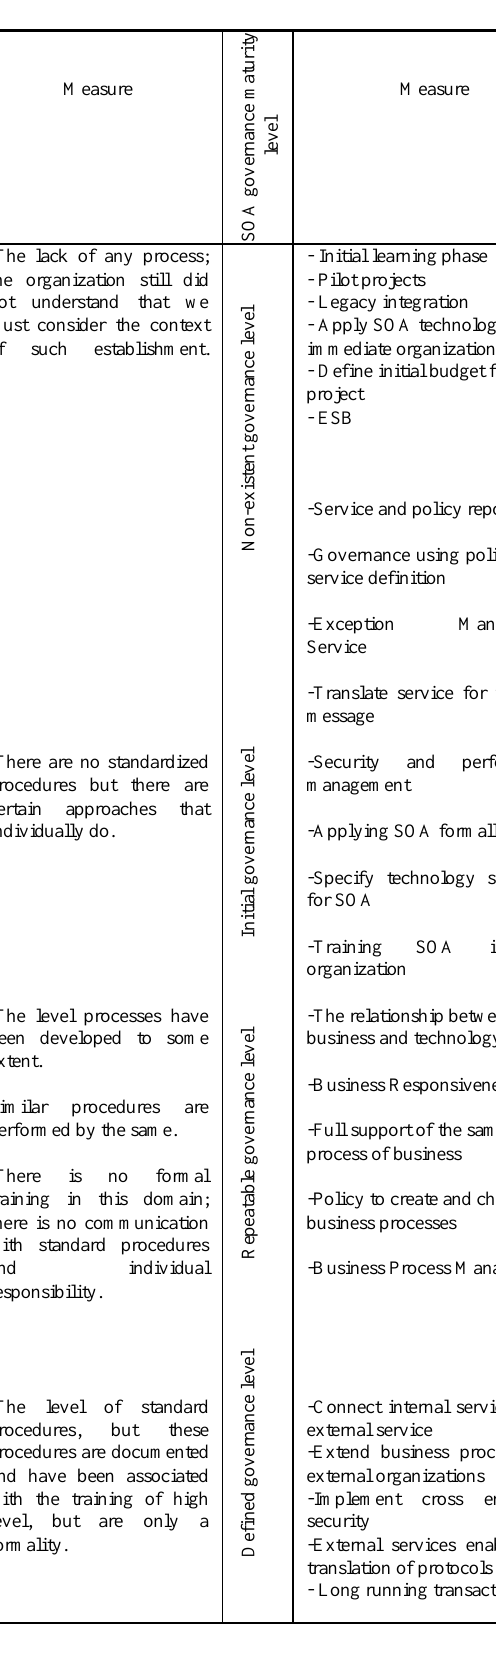
Table 4: Measure of process domain [21], SOA maturity levels, SOA adoption domain [3], and COBIT governance maturity levels